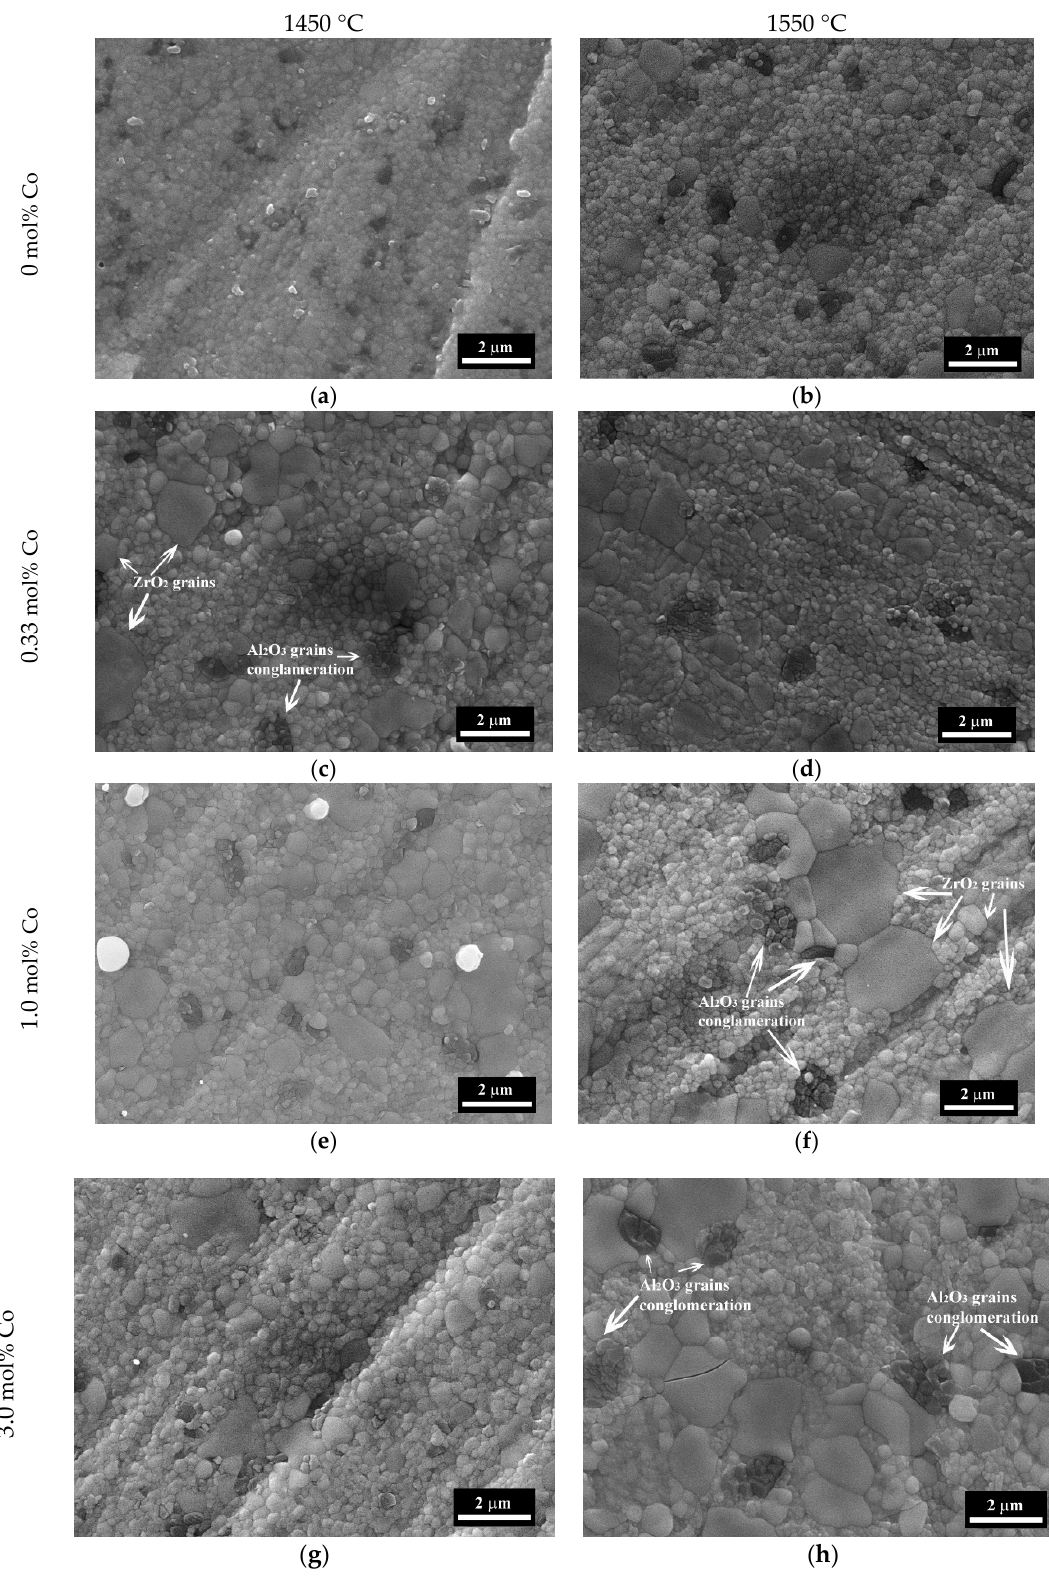
Figure 8. SEM images (SE mode) of 3Y-TZP-Al 2 O 3 ceramics: composition I ( a , b ), composition II ( c , d ), composition III ( e , f ), composition IV ( g , h ) sintered at 1450 ( a , c , e , g ) and 1550 °C ( b , d , f , h ).